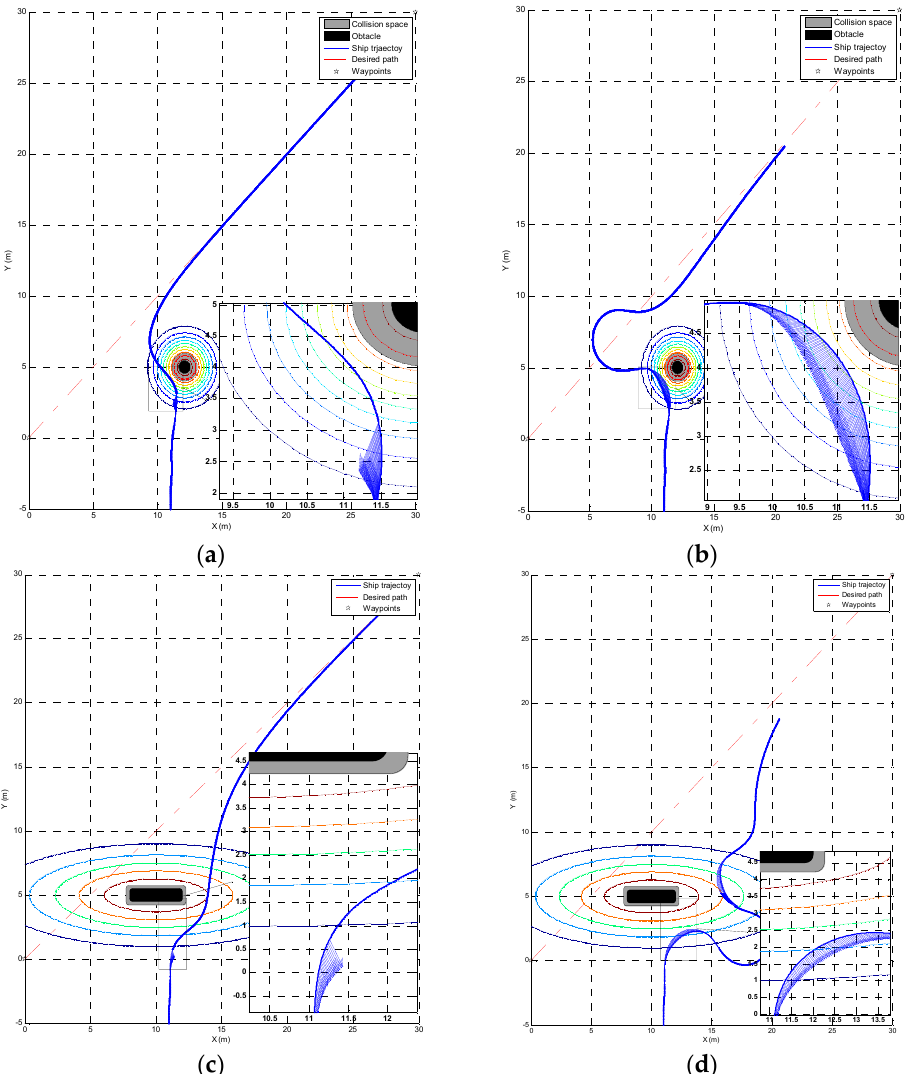
Table 1. The computational cost and path length in the simulations with a single obstacle.